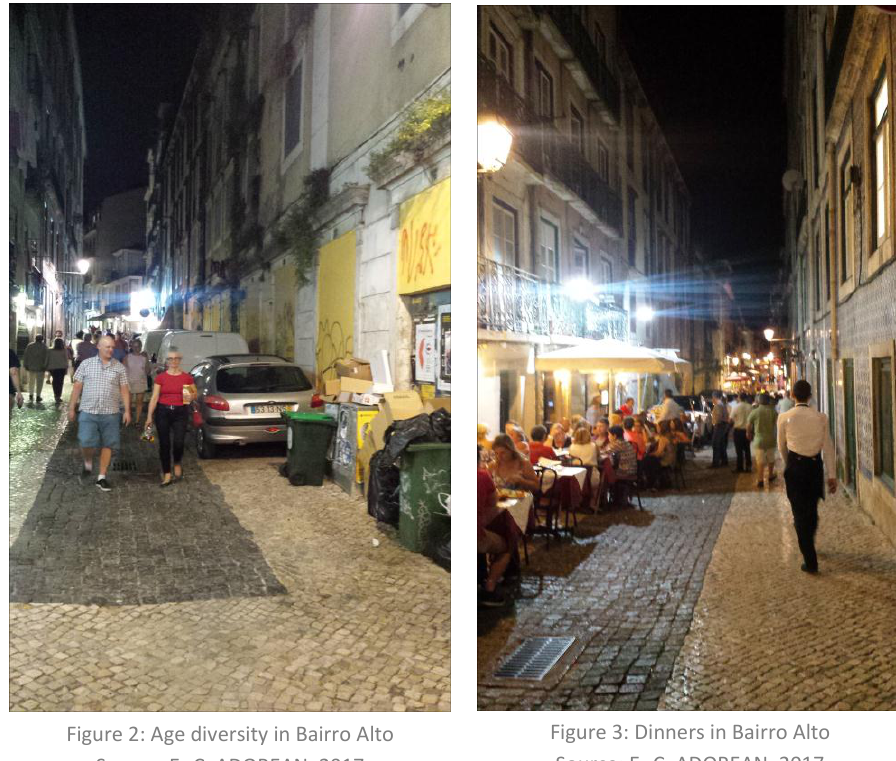
Figure 2: Age diversity in Bairro Alto Source: E.-C. ADOREAN, 2017